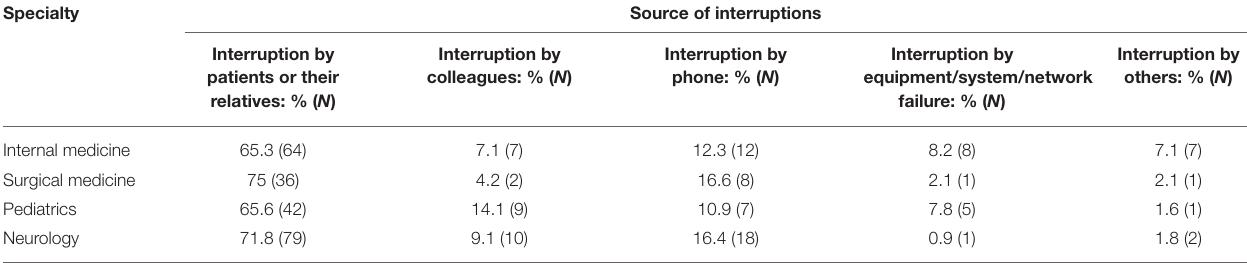
TABLE 6 | Sources of interruptions among the four specialties.